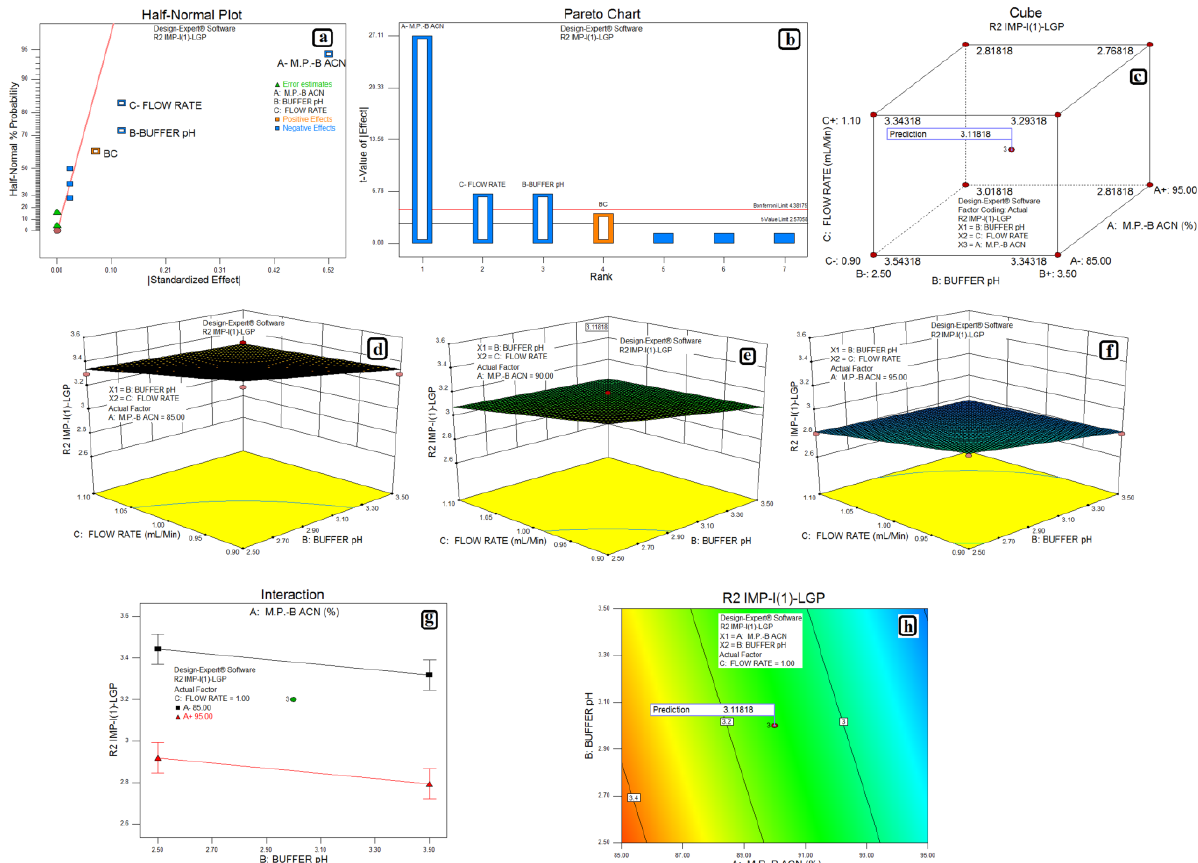
Figure 2. ( a ) Half-normal plot; ( b ) Pareto chart; ( c ) cube; ( d ), ( e ), and ( f ) 3D plots showing effect of % of ACN in mobile phase-B and pH of buffer on resolution R2; ( g ) effect on resolution R2 due to interaction between buffer pH and % of ACN in mobile phase-B; and ( h ) desirability of resolution between Impurity-I ( 1 ) and linagliptin (LGP).